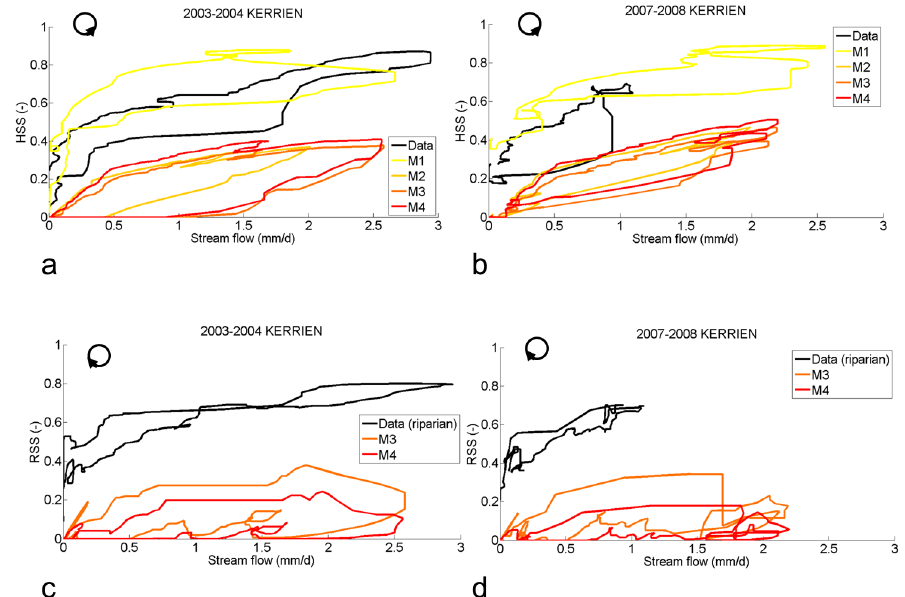
Figure 10. Observed and simulated annual hysteresis between stream flow ( Q ) and (a, b) saturated storage in the hillslope HSS (for observed hysteresis, HSS is the average of F5b and F4) and (c, d) saturated storage in the riparian area RSS (for simulated hysteresis, only M3 and M4 represent the riparian area), for the water years (a, c) 2003–2004 (wet year, calibration period) and (b, d) 2007–2008 (dry year, validation